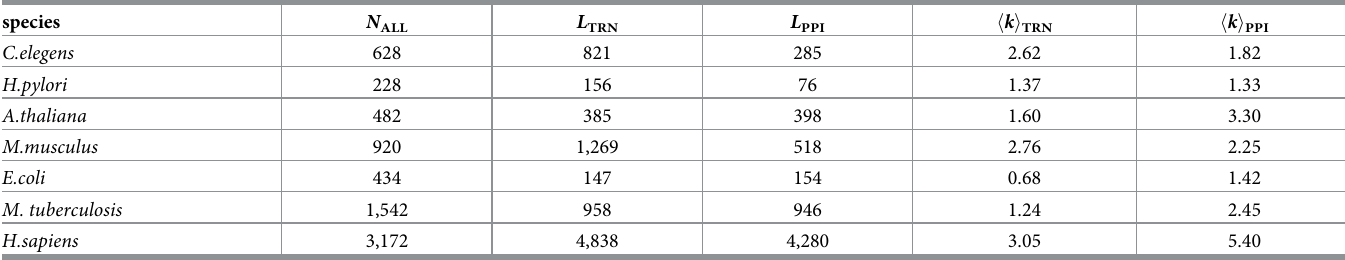
Table 1. The characteristics of the TRN-PPI multiplex networks for seven species. species N ALL L TRN L